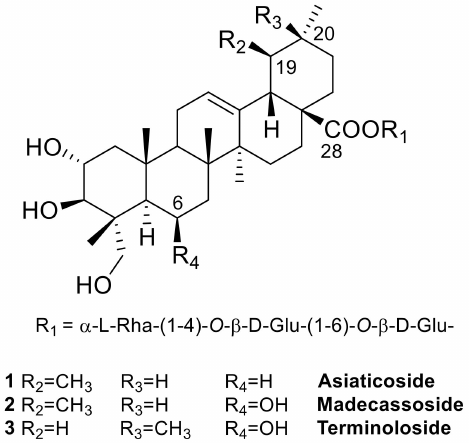
Figure 1. The main triterpene saponins isolated from C. asiatica